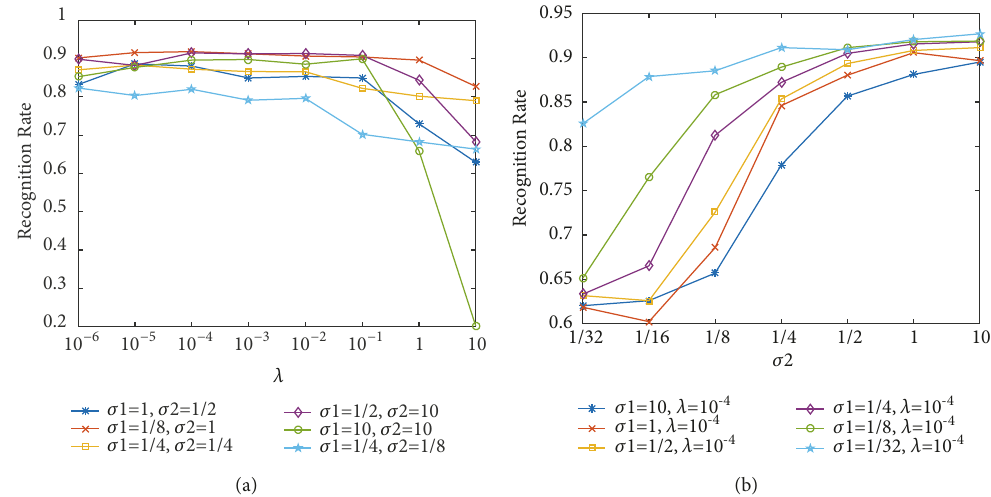
Figure 4: Face recognition rates of CoLR under different parameter settings on CMU PIE dataset [52]. (a) 𝜆 versus 𝜎 1 and 𝜎 2 ; (b) 𝜎 1 versus 𝜆 = 0.0001 𝜎 2 with